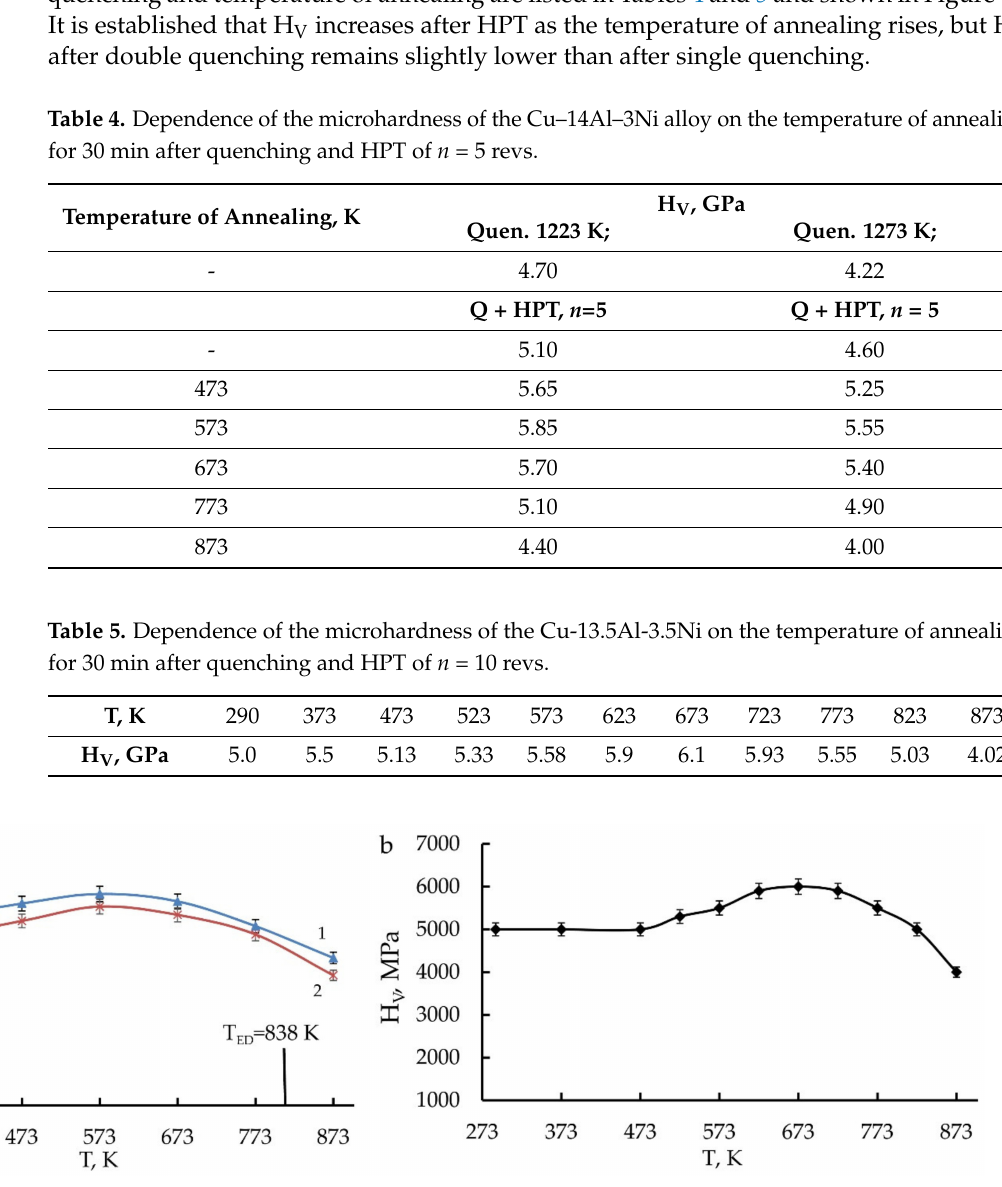
Figure 17. Dependence of the microhardness H V of the HPT-treated alloys ( a ) Cu–14Al–3Ni (curve 1–quenching from 1223 K, curve 2–quenching from 1273 K) and ( b ) Cu–13.5–3.5Ni on the temperature of annealing for 30